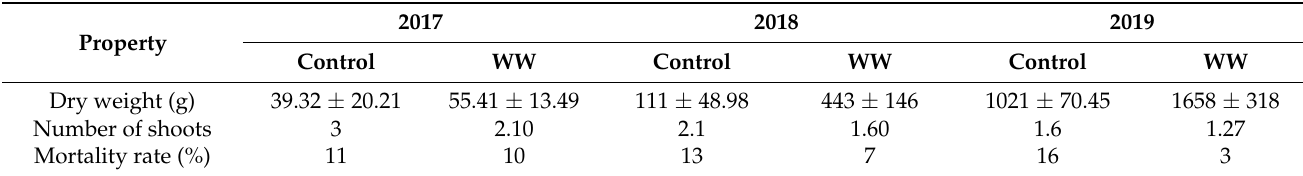
Table 6. Estimation of dry weight and number of shoots (mean ± SE, n = 30), and mortality rate (density-based) of willow under WW irrigation in different years.